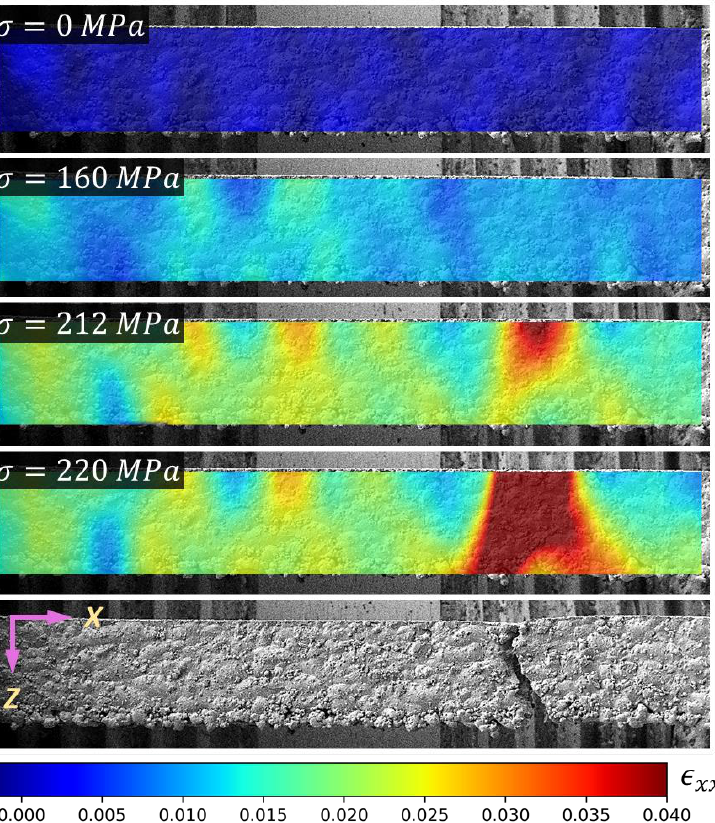
Figure 12. Demonstration of 2D DIC processing technique, namely continuous strain localisation tracking.